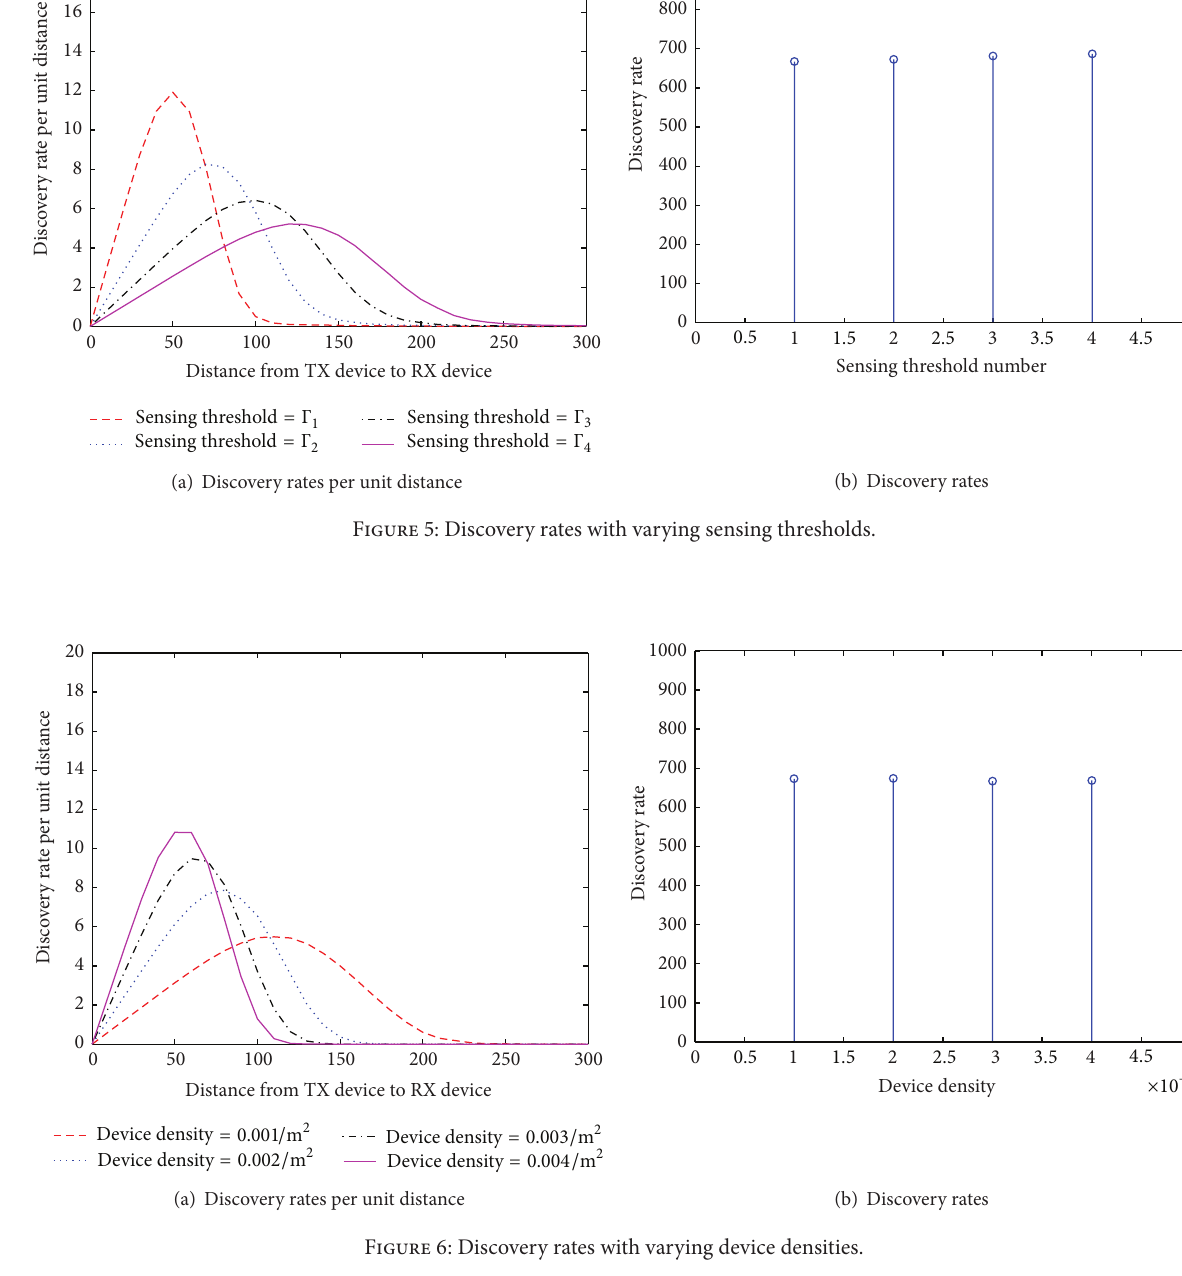
Figure 6: Discovery rates with varying device